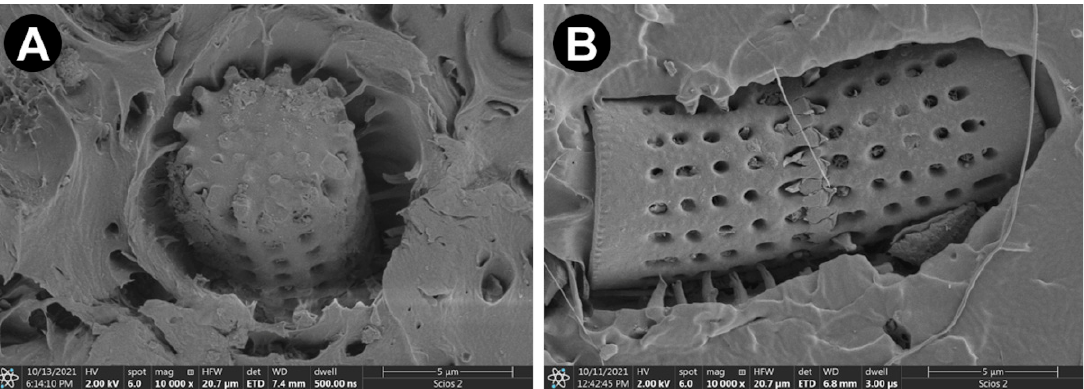
Figure 9. SEM images of the manufactured composites: ( A ) 3251-15, ( B ) 4043-5 showing the created unique structure.